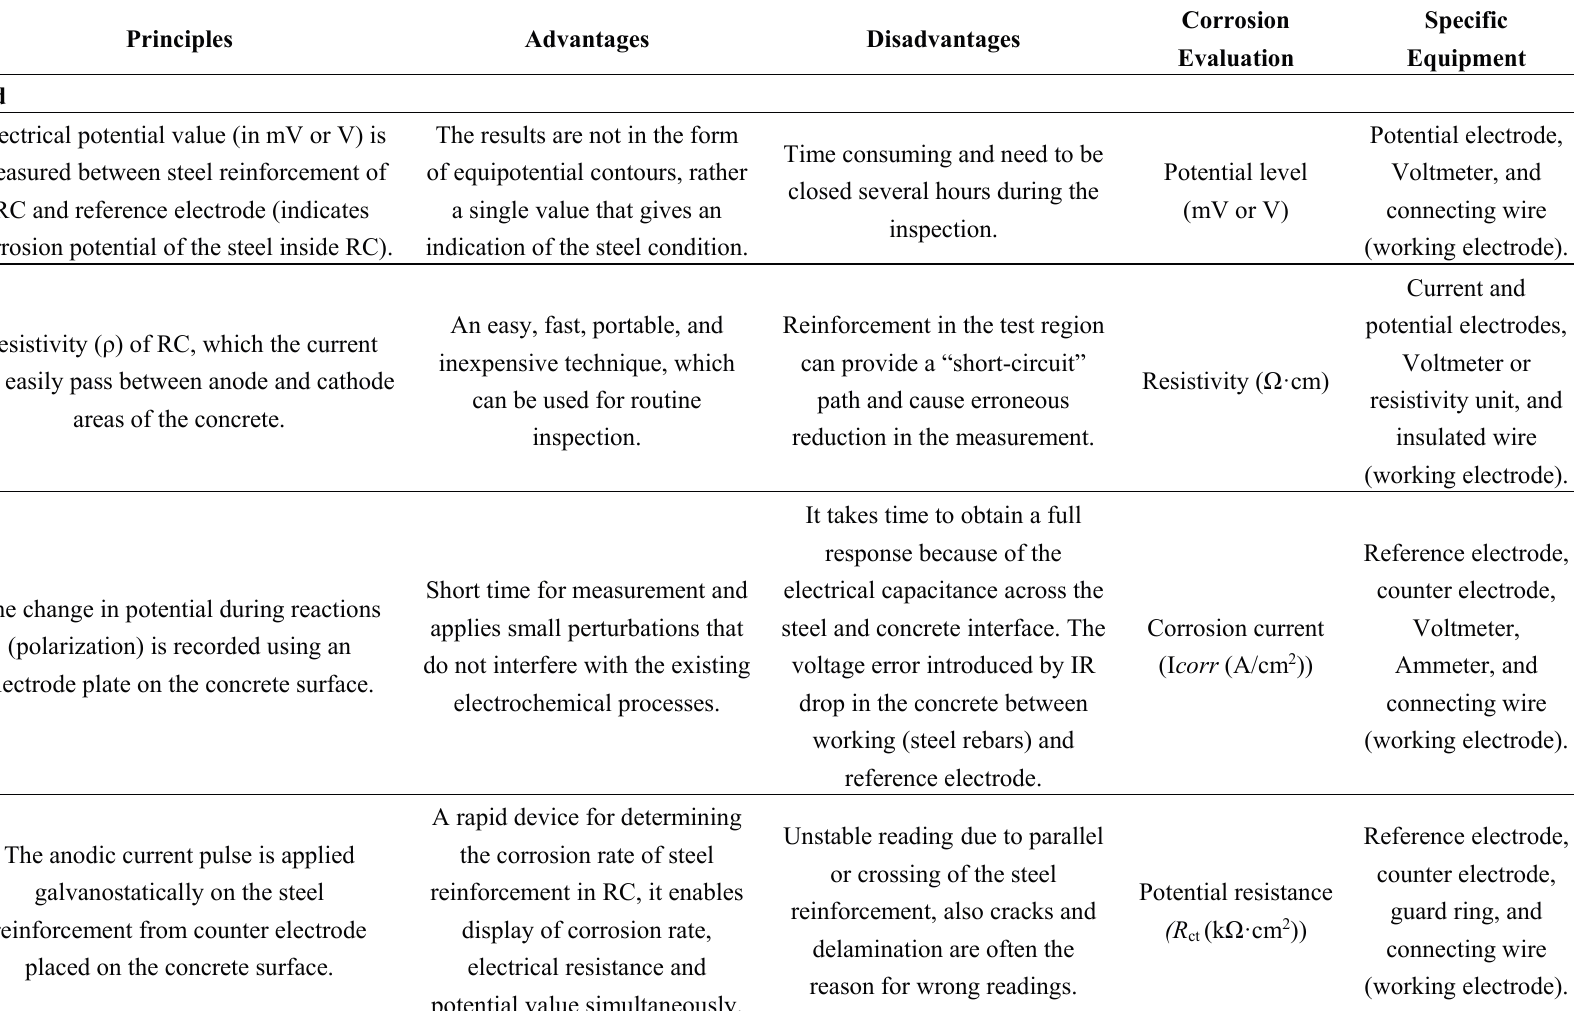
Table 2. Resume of NDT methods for corrosion